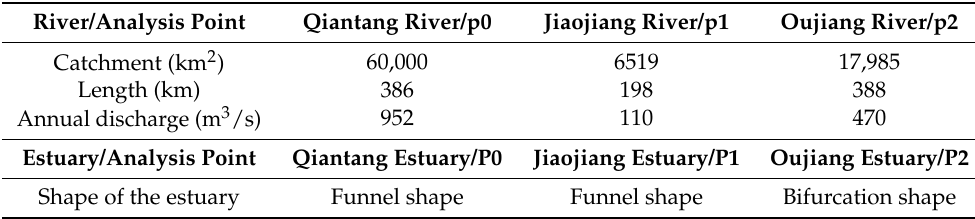
Table 1. Characteristics of the three largest rivers in Zhejiang